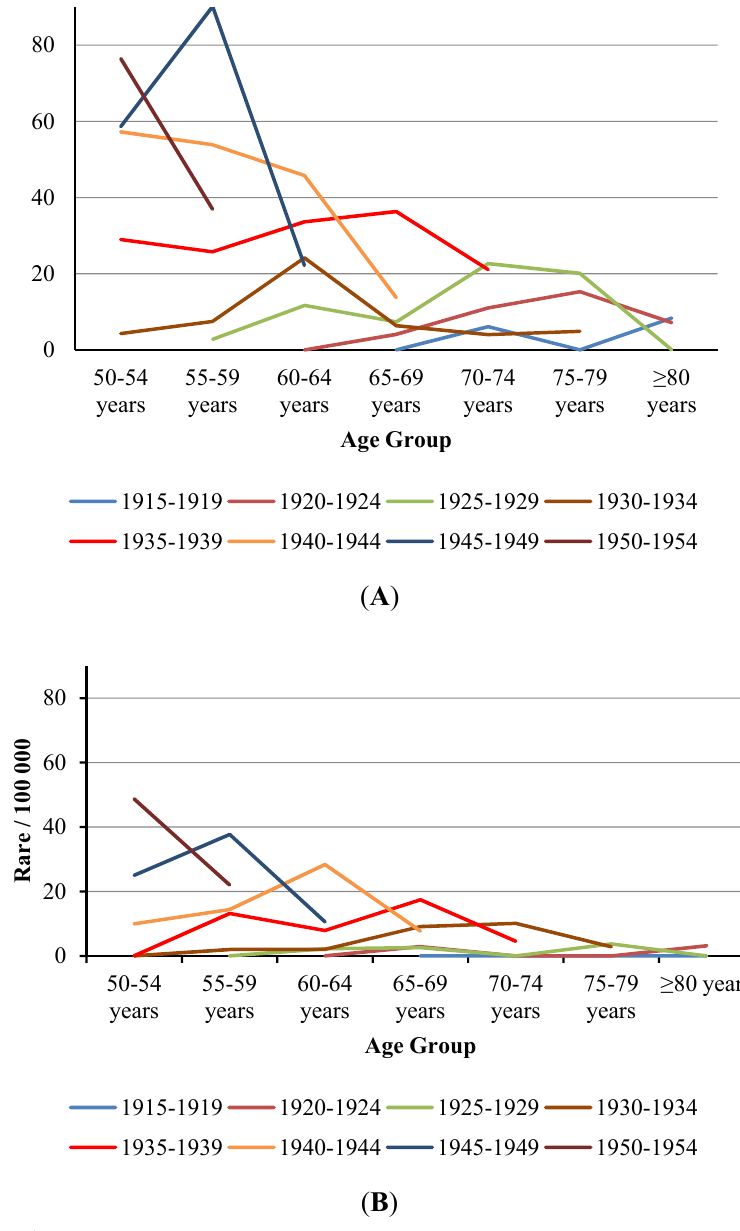
Figure 2. Trends of AIDS incidence 1 by period/100,000 in each birth-cohort (age ≥ 50 years) over 1982–2011. ( A ) male; ( B )